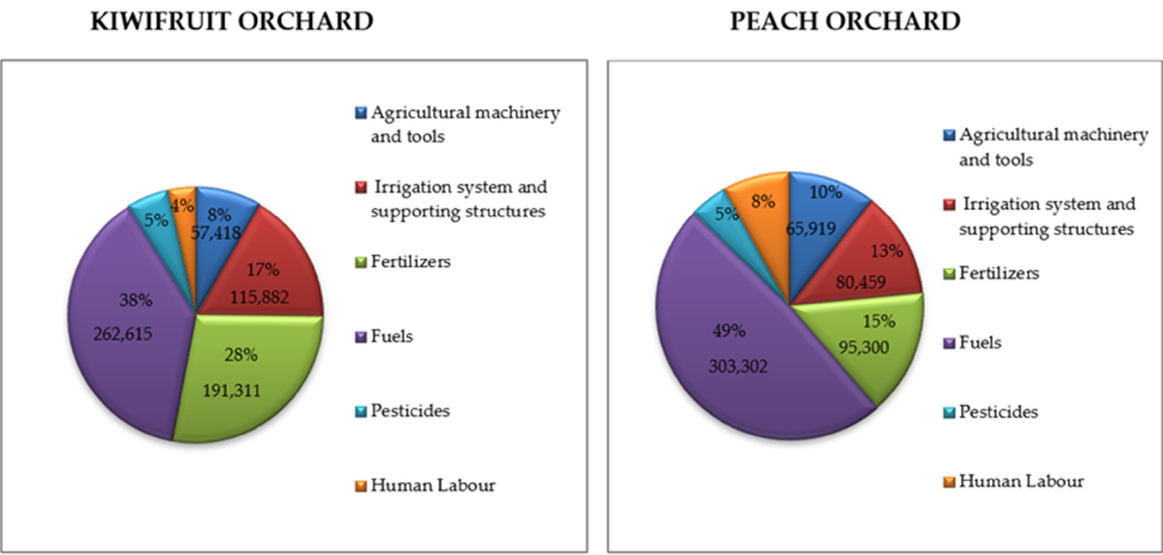
Figure 5. Percentage distribution of energy consumption by production factors.